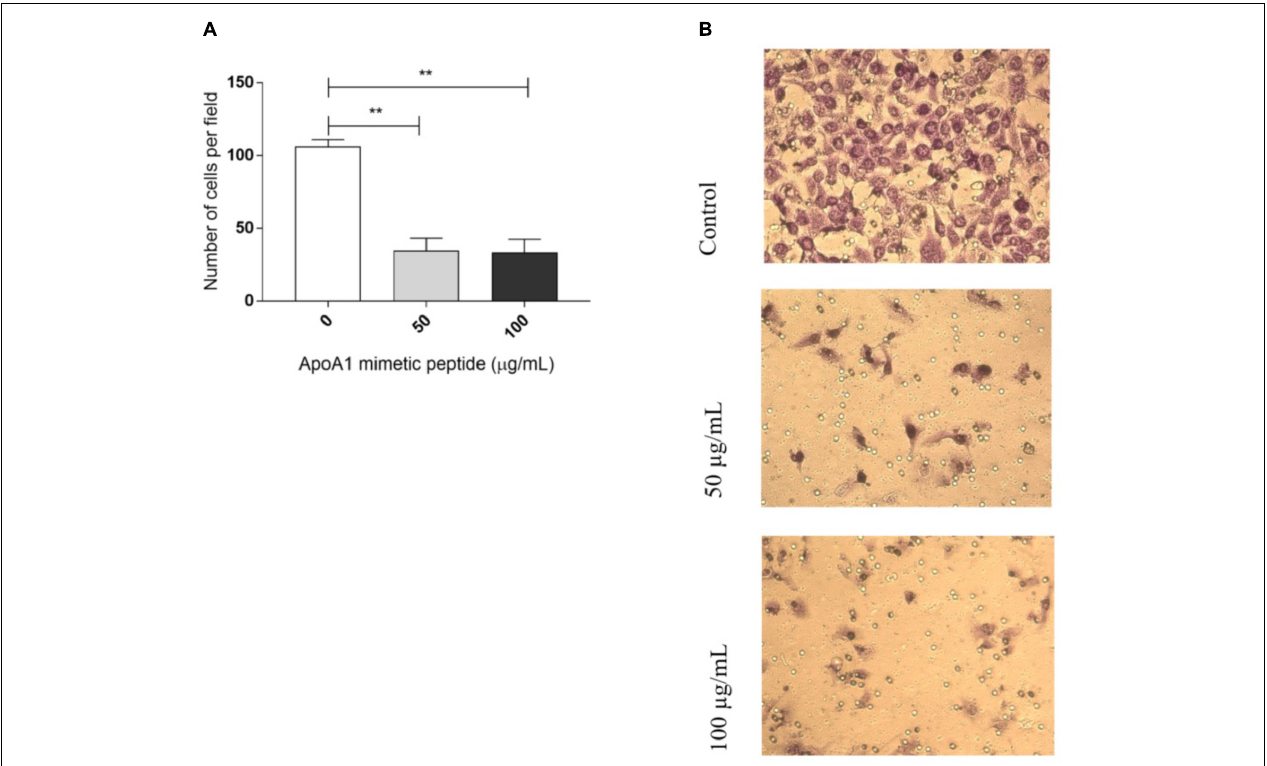
FIGURE 4 | The ApoA1 mimetic peptide hampers cancer cells invasion. A transwell migration assay was performed with SKOV3 cells exposed to the ApoA1 mimetic peptide at a concentration of 50 and 100 µ g/mL, and with unexposed SKOV3 cells (control). Exposure to the ApoA1 mimetic peptide at both concentrations significantly decreased the ability of SKOV3 cells to migrate and invade, comparatively to unexposed cells (Kruskal–Wallis test with Dunn’s post-test; control vs. 50 µ g/mL ApoA1 mimetic peptide: p = 0.0020; control vs. 100 µ g/mL ApoA1 mimetic peptide: p = 0.0016). In (A) , the number of cells per field is plotted for each condition. In (B) , it is shown three images representatives of each experimental condition. Differences were considered significant if p < 0.05. ∗∗ p < 0.001.